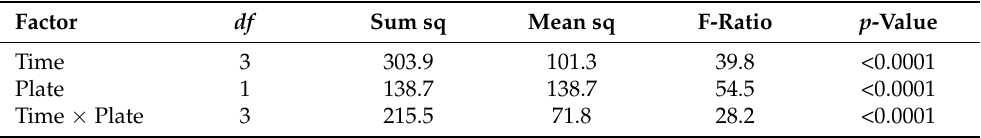
Figure 6. Length of juveniles on the two plates (CA and CB) from Time 1 to Time 4. The fish icon indicates the period during which plate A remained unprotected for 5 days ( n = 30), coloured box represents interquartile range, central bar represents the median, vertical lines indicate the largest values within 1.5 times the interquartile range above the 75 ◦ percentile or the smallest below the 25 ◦ percentile, black points are values more than 1.5 times and less than 3 times the interquartile range. *** p < 0.001 (2-ways robust ANOVA). Table 1. Two-ways robust ANOVA with repeated